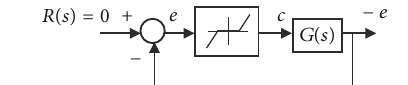
Figure 5: Equivalent representation of block diagram in Figure